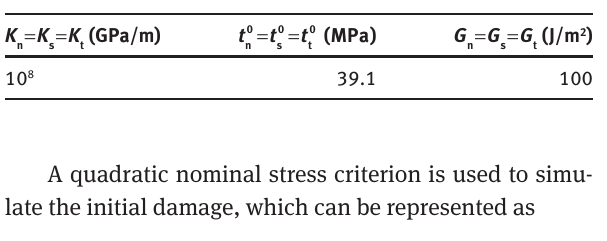
Table 3: Material parameters of the